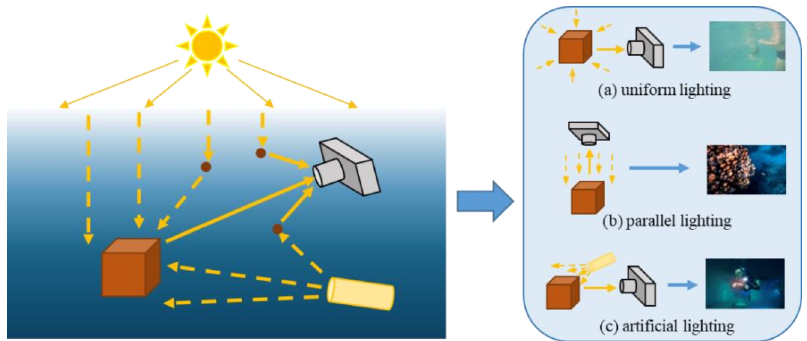
Figure 2. Approximating complicated real-world underwater illumination with the combination of uniform lighting, parallel lighting, and artificial